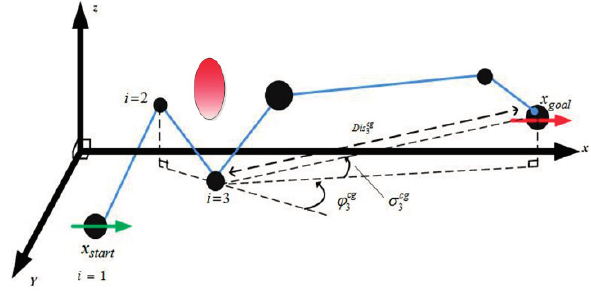
Figure 5. Computing (cid:2030) (cid:2871)(cid:3030)(cid:3034) and (cid:2026) (cid:2871)(cid:3030)(cid:3034)